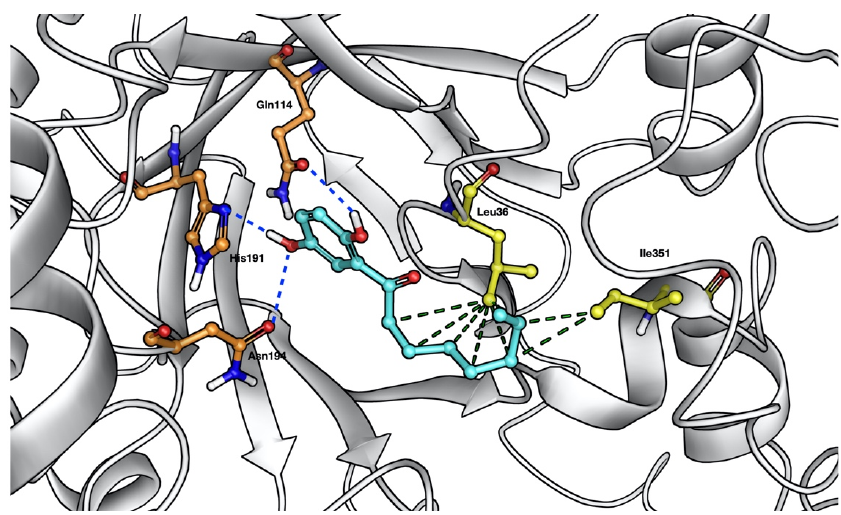
Figure 3. Molecular docking value of octanoylbenzohydroquinone 4 (light blue) against Candida albicans NADPH dehydrogenase. Polar interactions are depicted as blue dotted lines and hydrophobic interactions as green dotted lines. Residues forming region P1 and H are represented in orange and yellow, respectively. Both residues and molecules are shown as sticks.